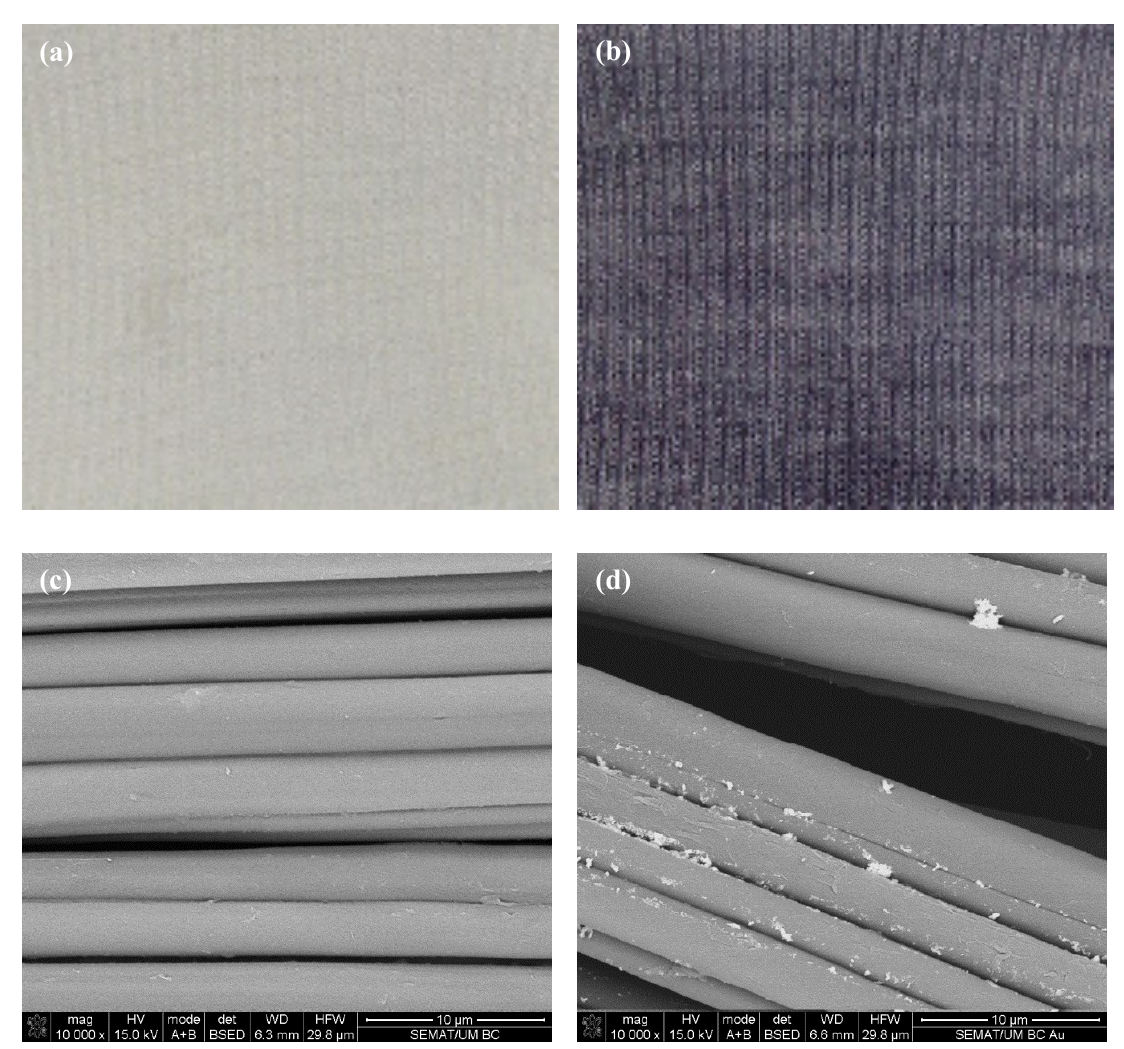
Figure 3. Visual results and scanning electron microscope (SEM) micrographs at 10,000 × magnifications of soybean fabrics ( a , c ) bare and ( b , d ) functionalised with AuNPs via 20% v/v chitosan.